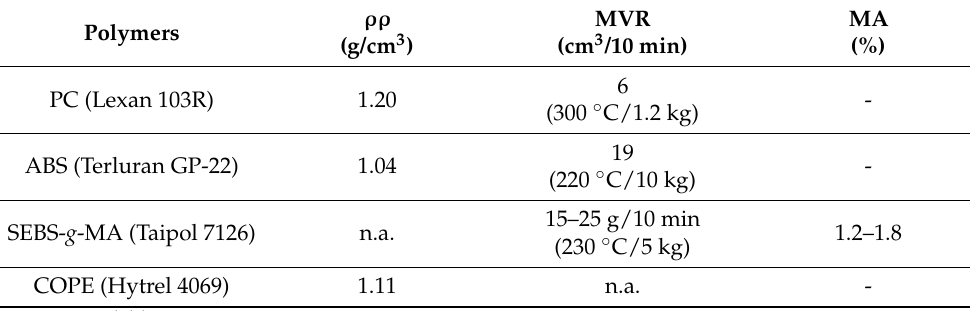
Table 1. Polymer characteristics according to datasheet.